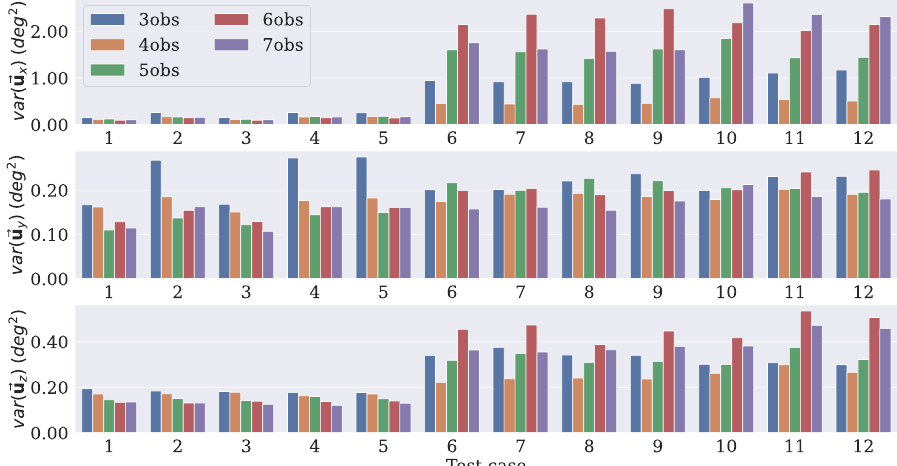
Figure 6. Uncertainties in the axes for each test case considering a dropout rate of